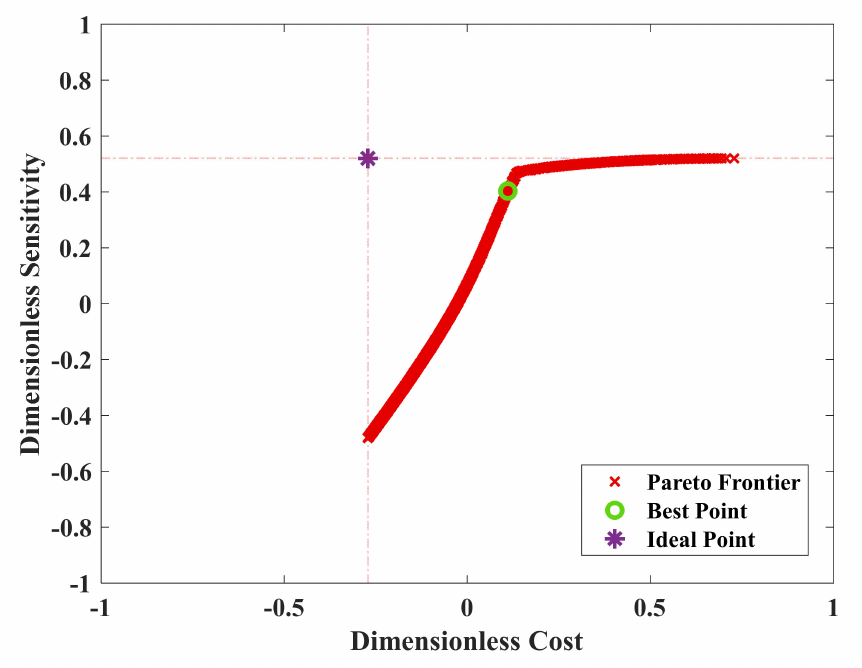
Figure 8. Dimensionless Pareto Frontier of cost and sensitivity as a result of optimization for nanocom- posite sensor with 1.25%